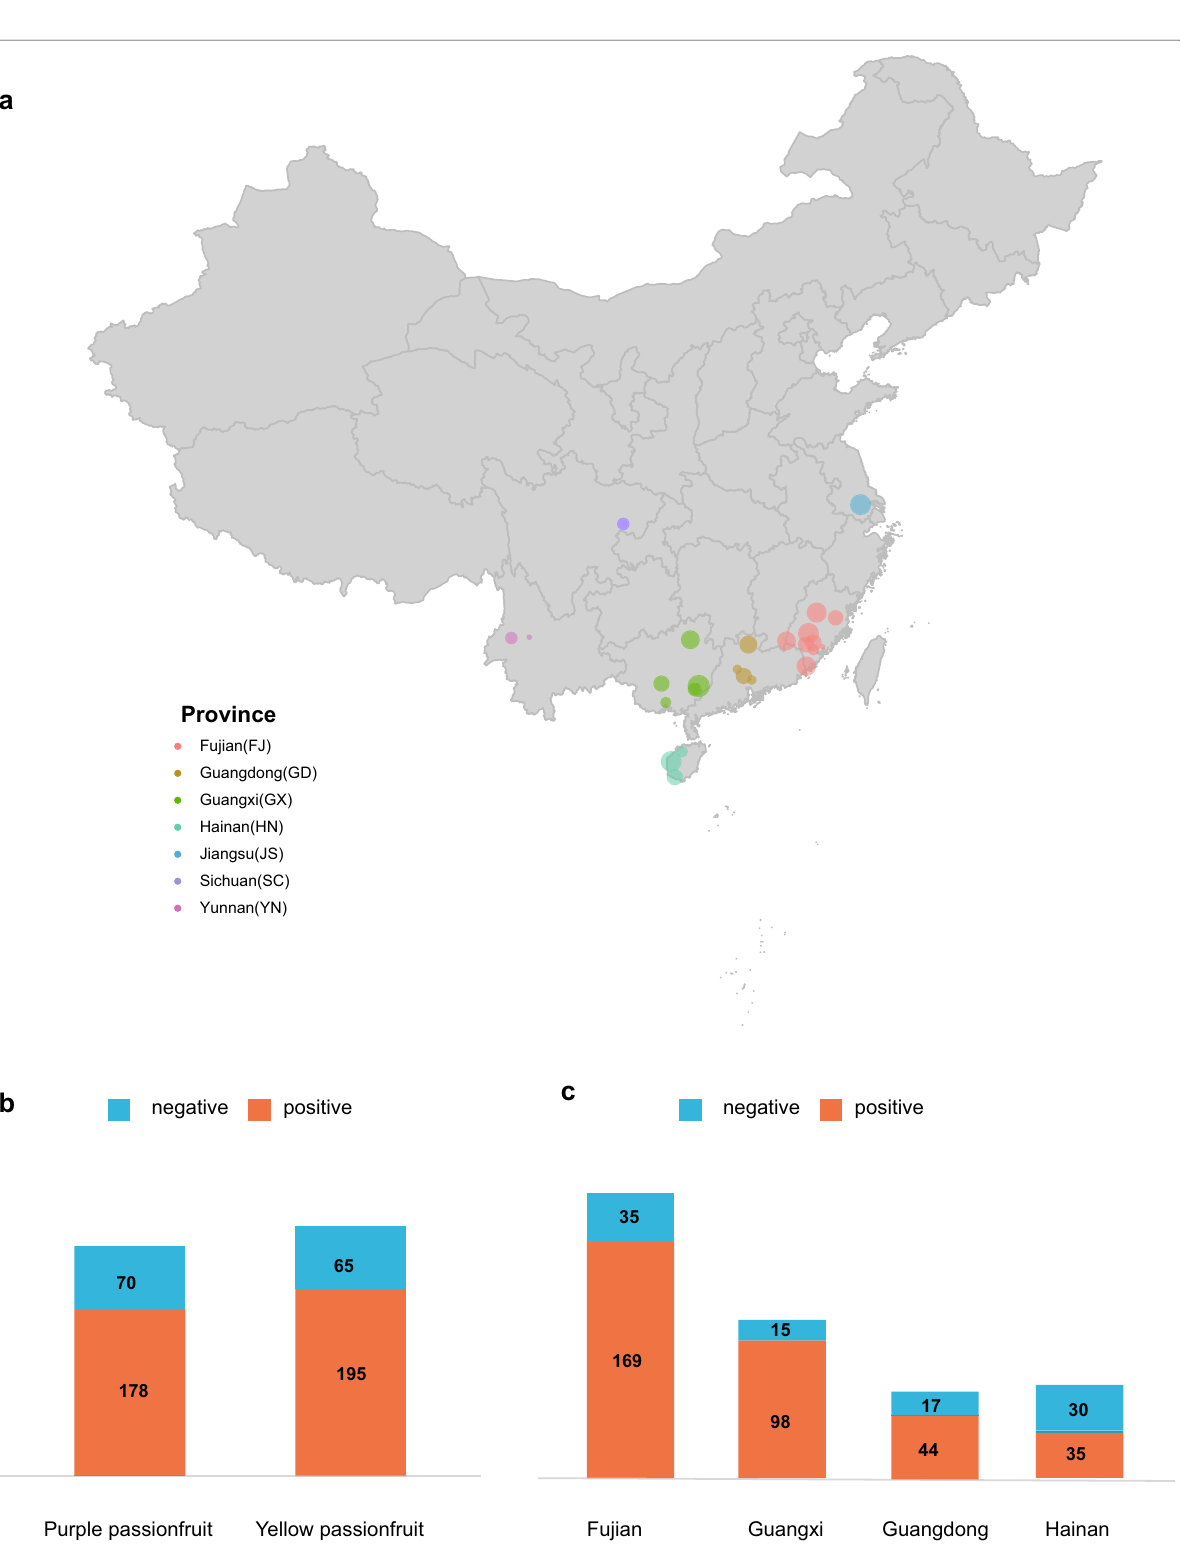
Fig. 1 The incidence of TelMV in China’s mainland. a Map showing the location of TelMV isolates collected in this study. b TelMV detection rates from purple and yellow passionfruit plants. c TelMV detection rates from passionfruit plant samples collected from Fujian, Guangxi, Guangdong